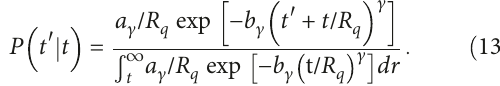
, t = 2 R , t = 5 R together with q q q